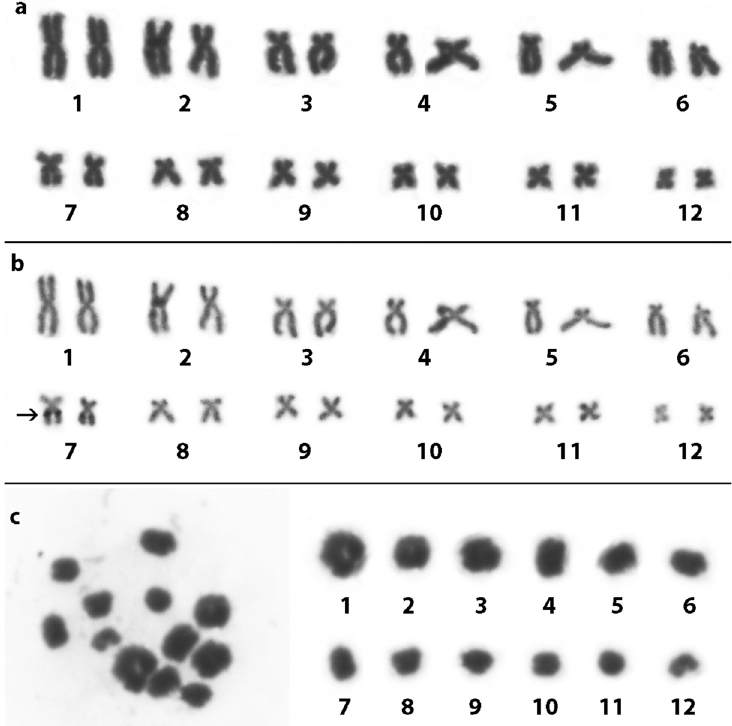
Figure 2 - Karyotype of Scinax constrictus (ZUFG8715) stained with 10% Giemsa (a) , Ag-NOR impregnation (ZUFG9310) (b) and meiotic bivalents (ZUFG8718) (c) The arrow in (b) shows the localization of the NOR.